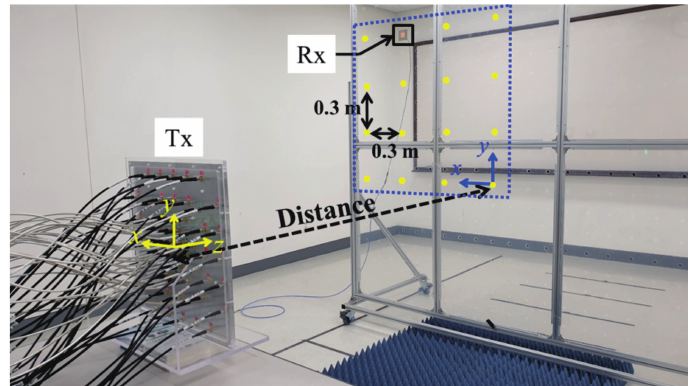
Figure 16. RF WPT experimental set-up (2): according to the Rx position.